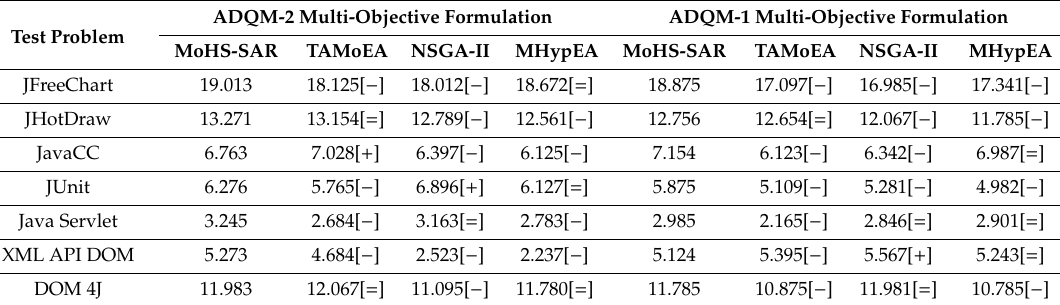
Table 4. MQ as an assessment criterion.